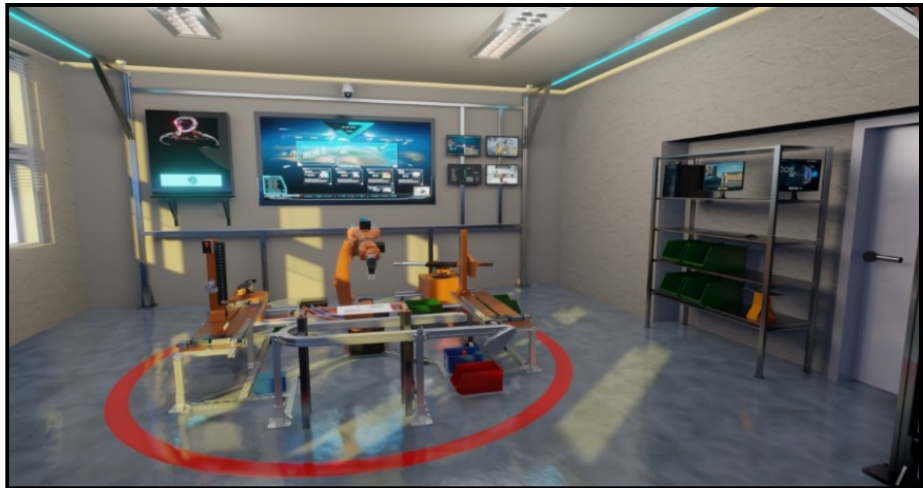
Figure 4. The digital version of CPS